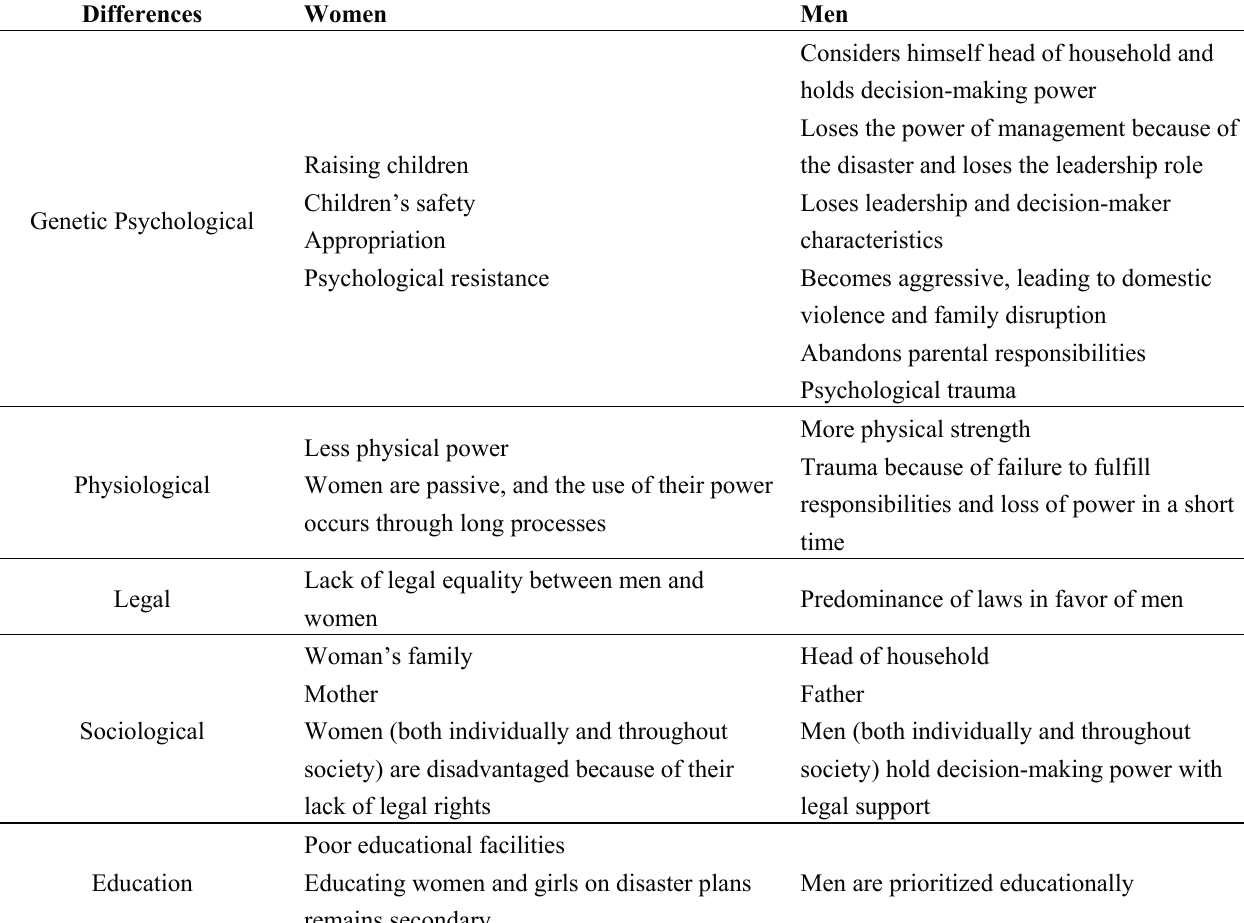
Figure 3. Schematic representation of a gender-oriented disaster management cycle. Table 1. Different needs and priorities of men and women following disasters in Turkey. Genetic and psychological differences are discussed